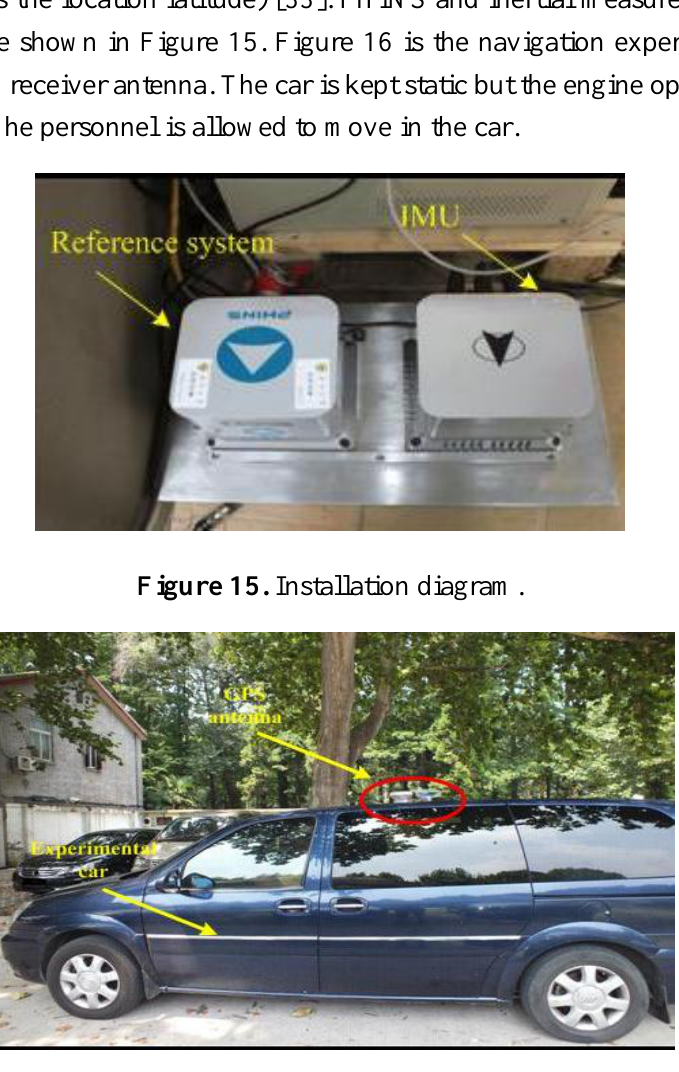
Figure 16. Experimental